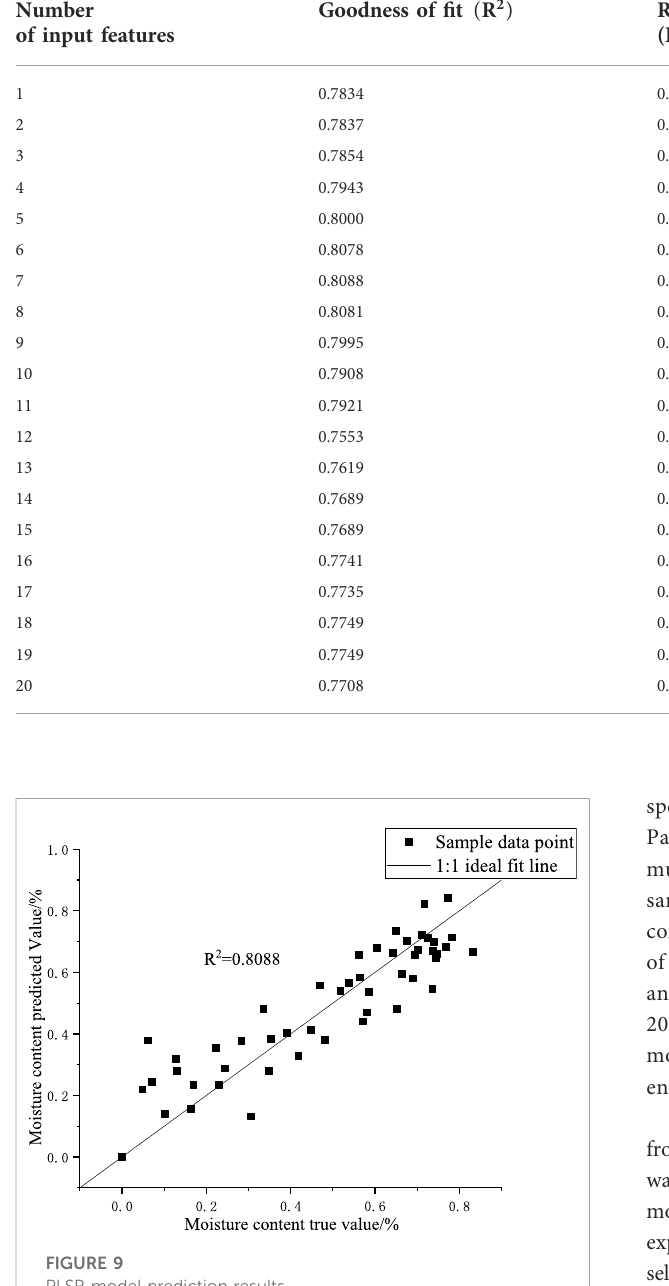
FIGURE 9 PLSR model prediction